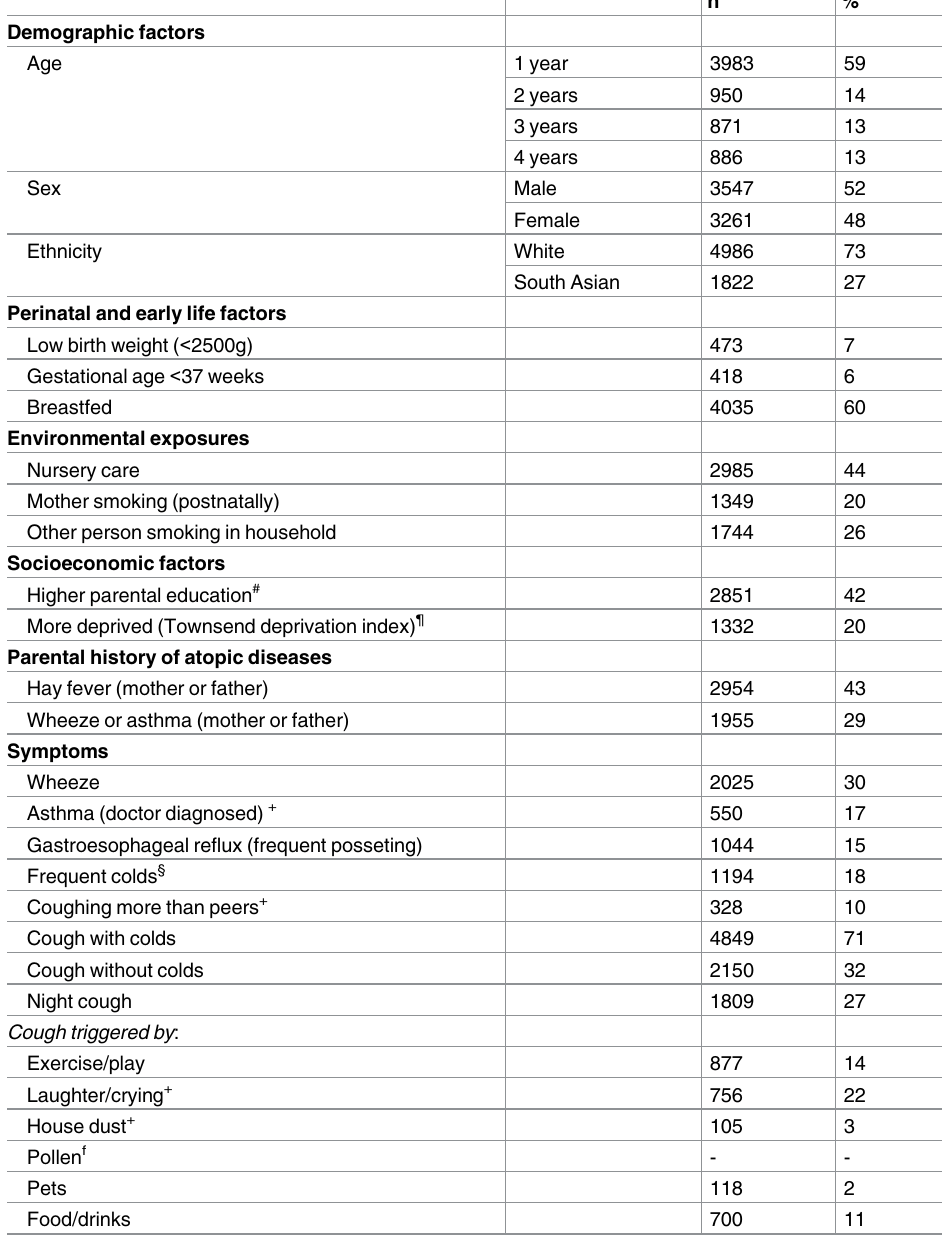
Table 2. Characteristics of the study population in 1998 (N =